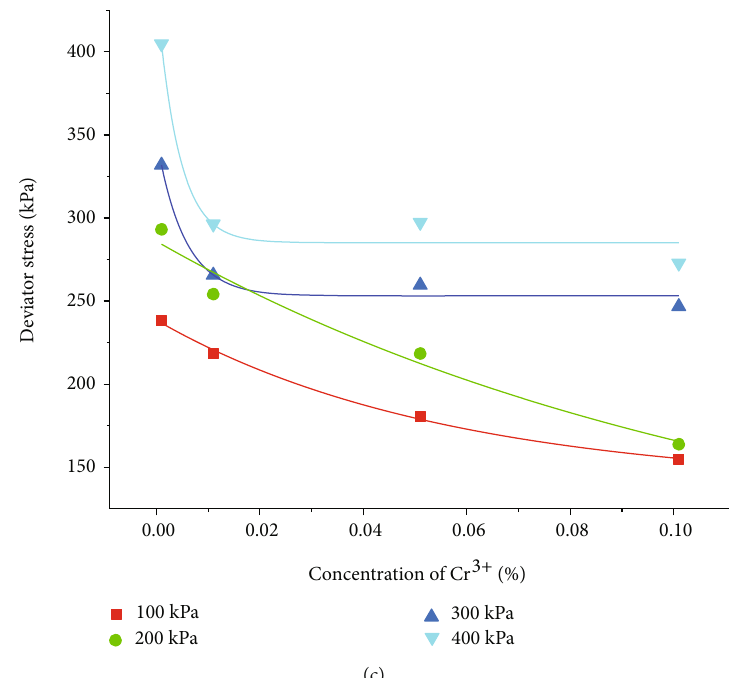
Figure 4: The relationship between chromium ion concentration and deviator stress. (a) The initial dry density is 1.35 g/cm 3 . (b) The initial dry density is 1.40 g/cm 3 . (c) The initial dry density is 1.45g/cm 3